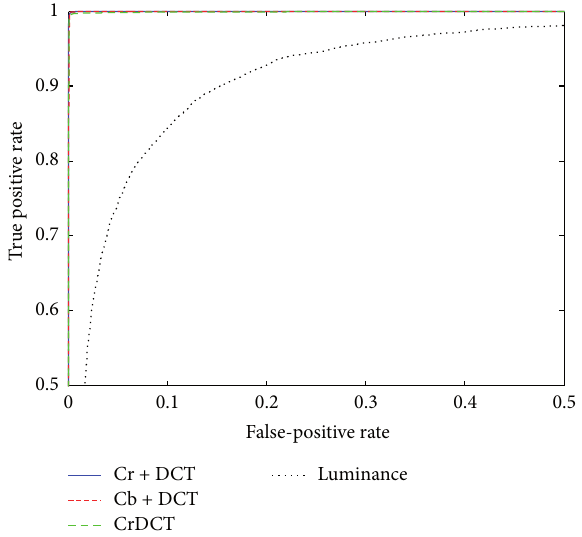
Figure 10: ROC curves for detection results of YCbCr channel on the CASIA v2